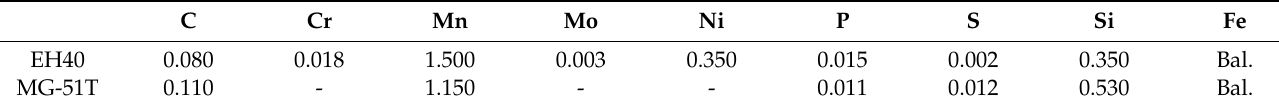
Table 1. The processing parameters and ranges used in this study are shown in Table 2. Table 1. Nominal compositions of EH40 plates and MG-51T wire (wt%).